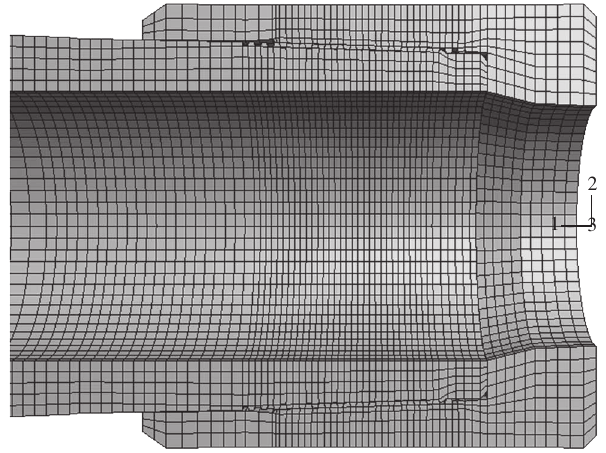
Figure 16. Detail of the mesh in the region of